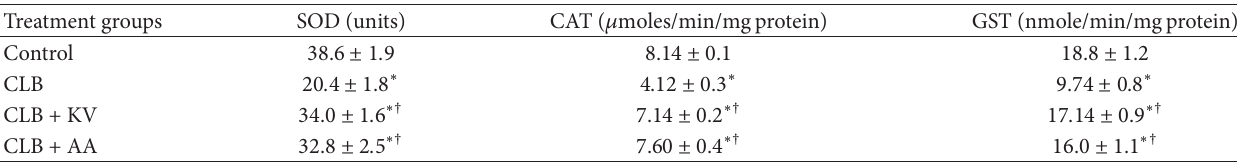
Table 1: Protective effect of kolaviron and L-ascorbic acid on chlorambucil-induced changes in testicular SOD, CAT, and GST activities in rats.